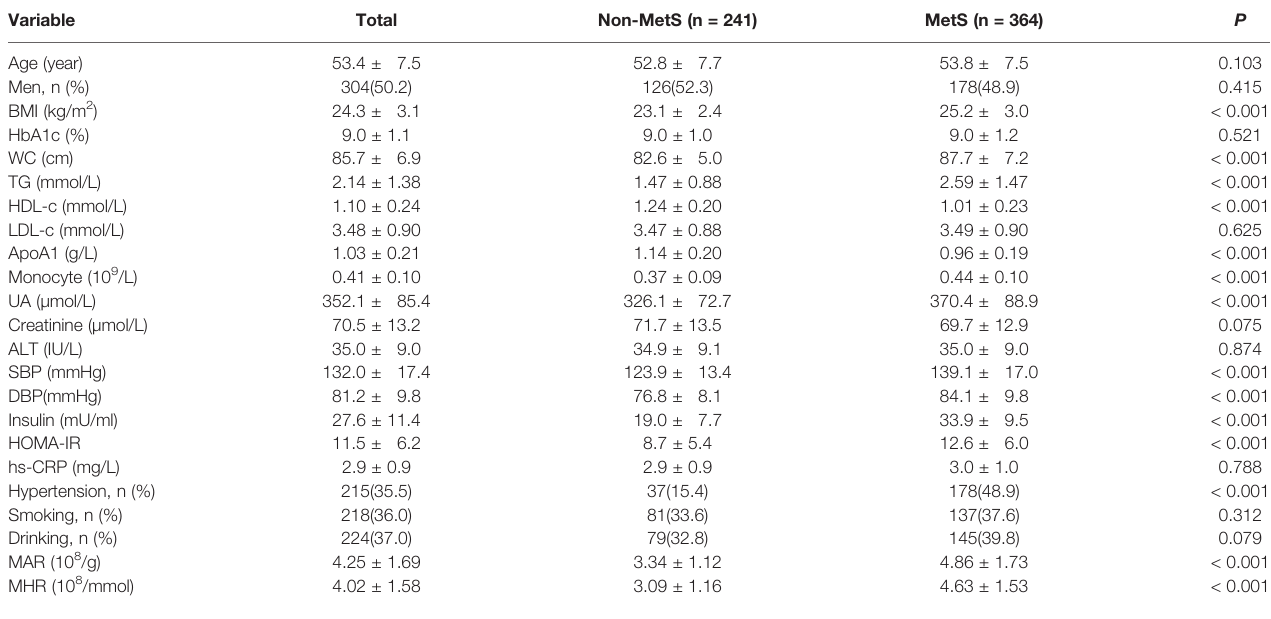
TABLE 1 | Clinical and laboratory characteristics of participants.